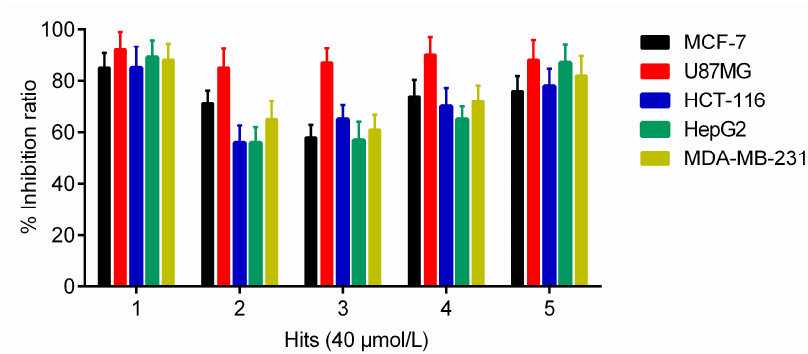
Figure 4. Growth inhibition effects of selected hits 1–5 on five tumor cells (MCF-7, U87MG, HCT-116, HepG2, and MDA-MB-231). The results are representative of three independent experiments and are expressed as mean ± SD.